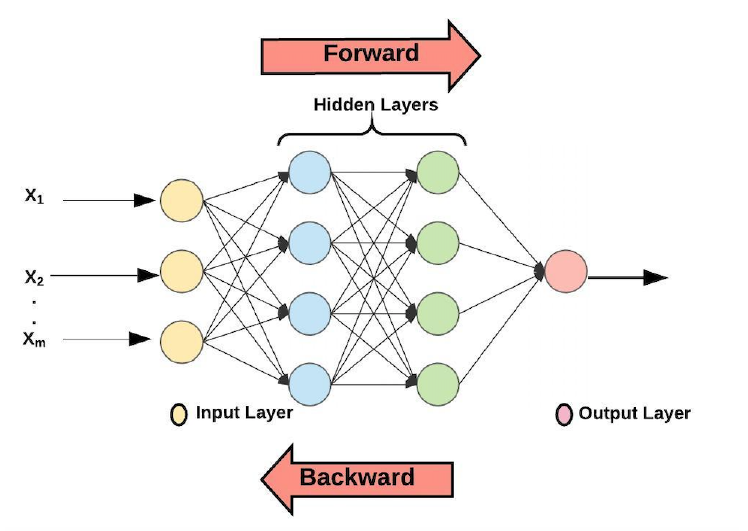
Figure 5. A general visualization explaining the MLP forward and backward